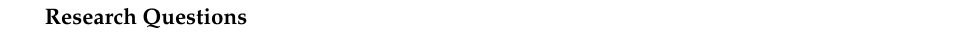
Table 1. Research